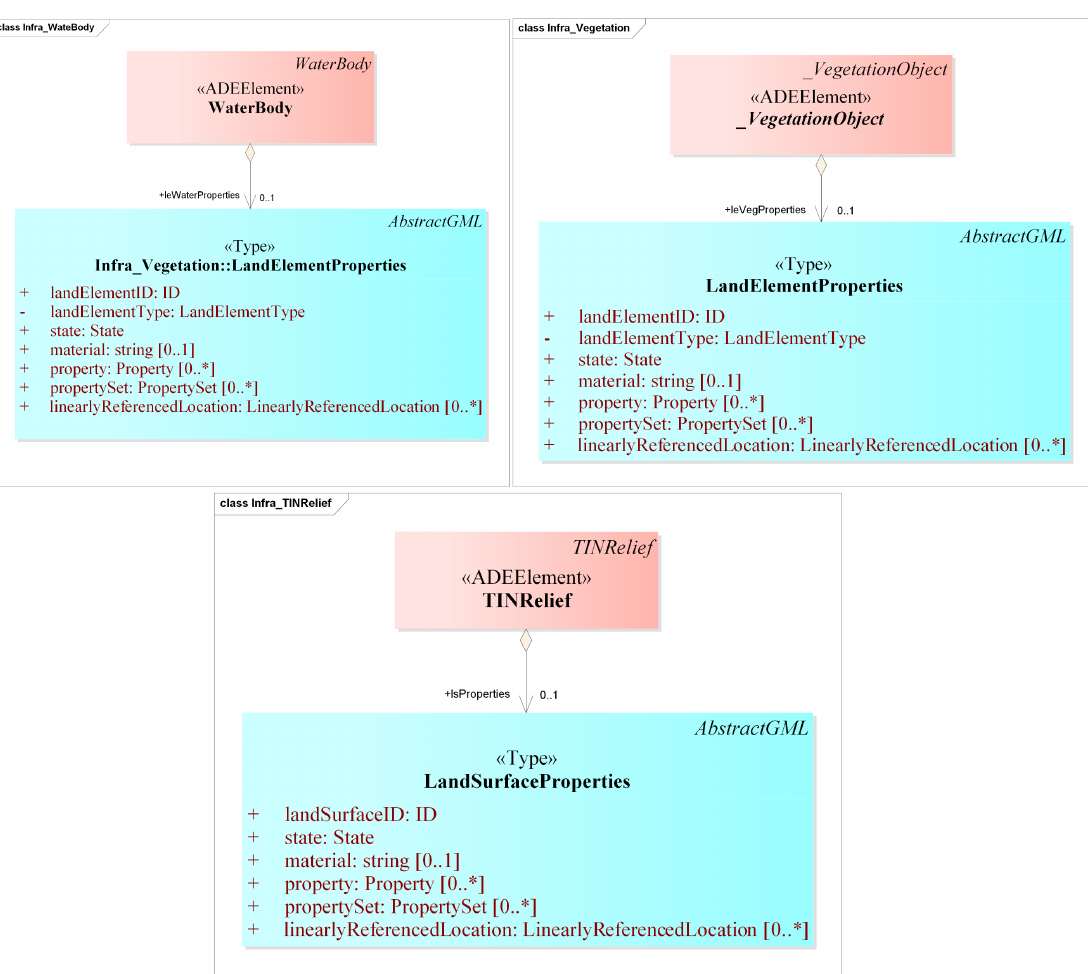
Figure A1. The UML excerpt depicts existing CityGML classes of CG::TINRelief , CG::WaterBody , CG::PlantCover , CG::SolitaryVegetationObject extended to include attributes from LandInfra LI::LandSurface , and LI::LandElement classes, respectively, in the CityGML Infra ADE.